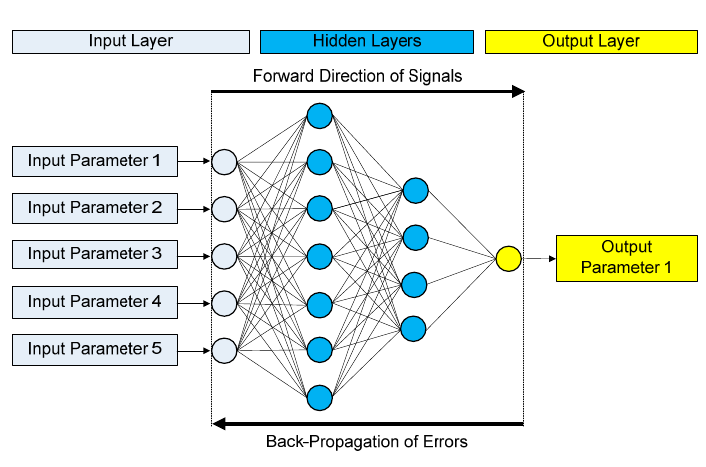
Figure 1. Architecture of a 5-7-4-1 BPNN model.